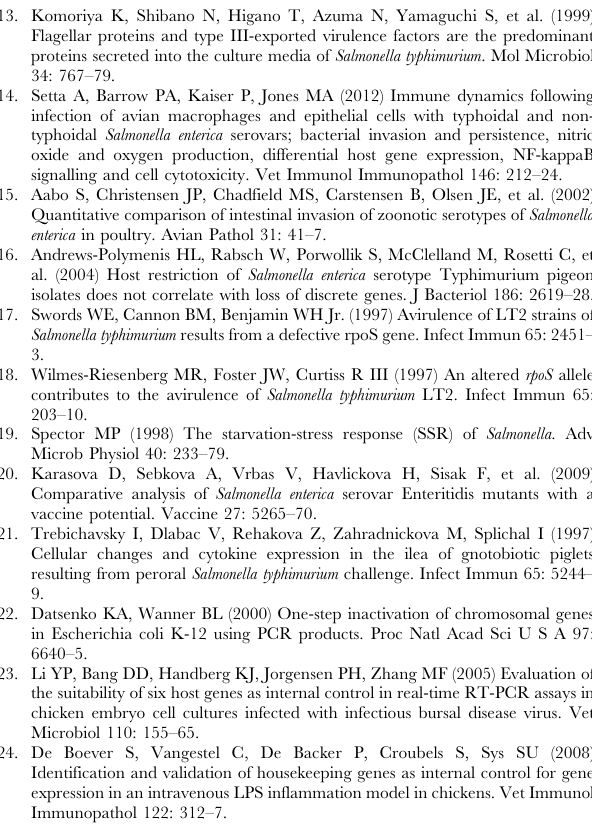
Table S1 Complete list of gene expression for each gene and chicken. Table S2 List of primers used in SybrGreen real time reverse transcription PCR in this